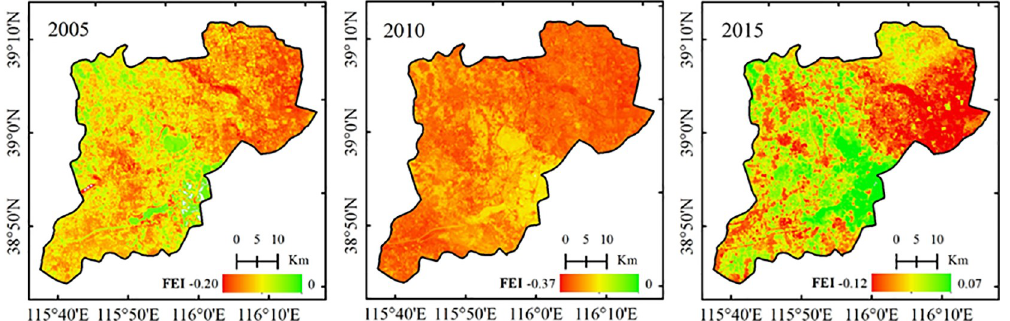
Fig 7. Water conservation function for the Xiongan New Area in 2005, 2010 and